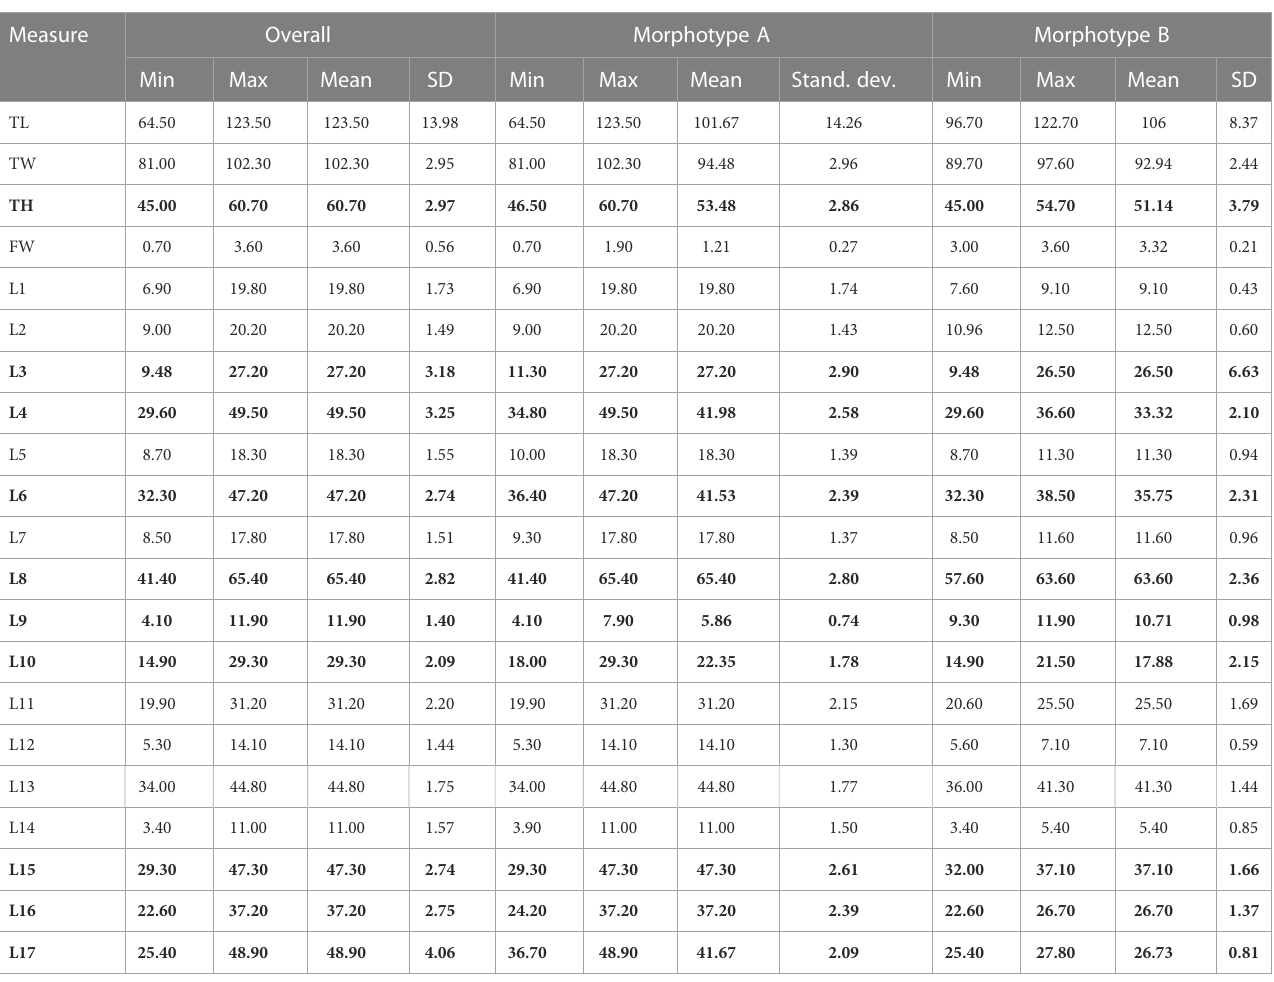
TABLE 2 Morphometric measurements in recent spatangids.